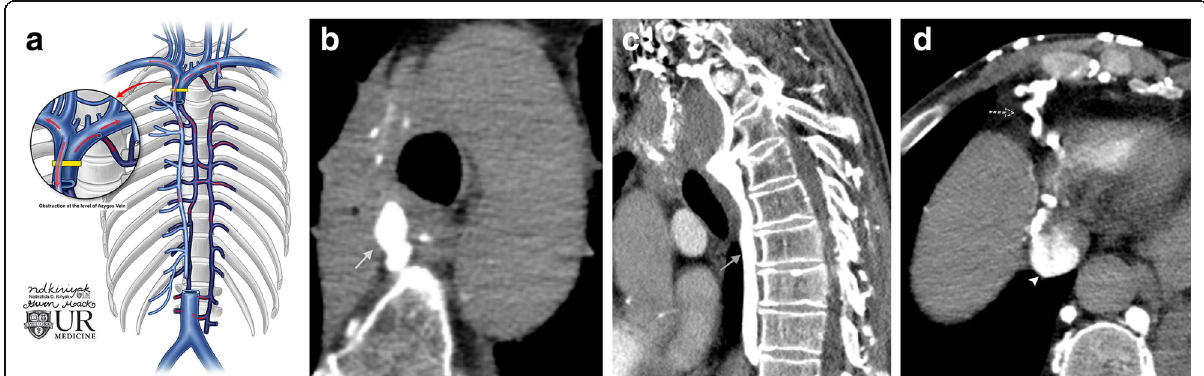
Fig. 10 Blockage of the SVC at the level of the azygos vein. a Schematic image of a SVC obstruction at the level of the azygos vein and pathway for collateral flow. b Axial CT image in a patient with a right hilar mass at the level of the SVC/azygous junction, causing the azygos vein (gray arrow) to become dilated. c Coronal CT image in the same patient demonstrating a prominent azygos vein (gray arrow) shunting blood inferiorly toward the IVC. d Blood from the azygos system in this patient is eventually shunted through collateral vessels (dashed arrow) into the IVC (arrowhead) bypassing the SVC blockage at the level of the azygos